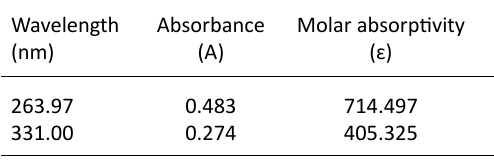
Table 5. Molar absorptivity (ɛ) values of the